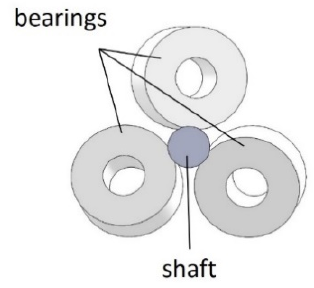
Figure 7. Bearing outer edges in contact with the shaft at specific angles. Table 2. Features of fused deposition modeling (FDM) and Polyjet additive manufacturing (AM) methods.